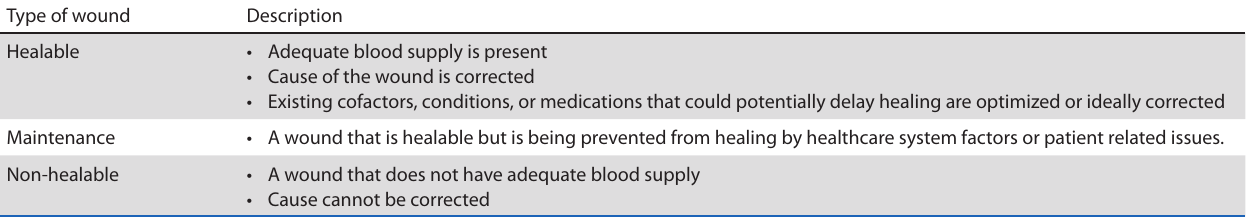
Table 9: Healable, maintenance or non-healing wounds 3